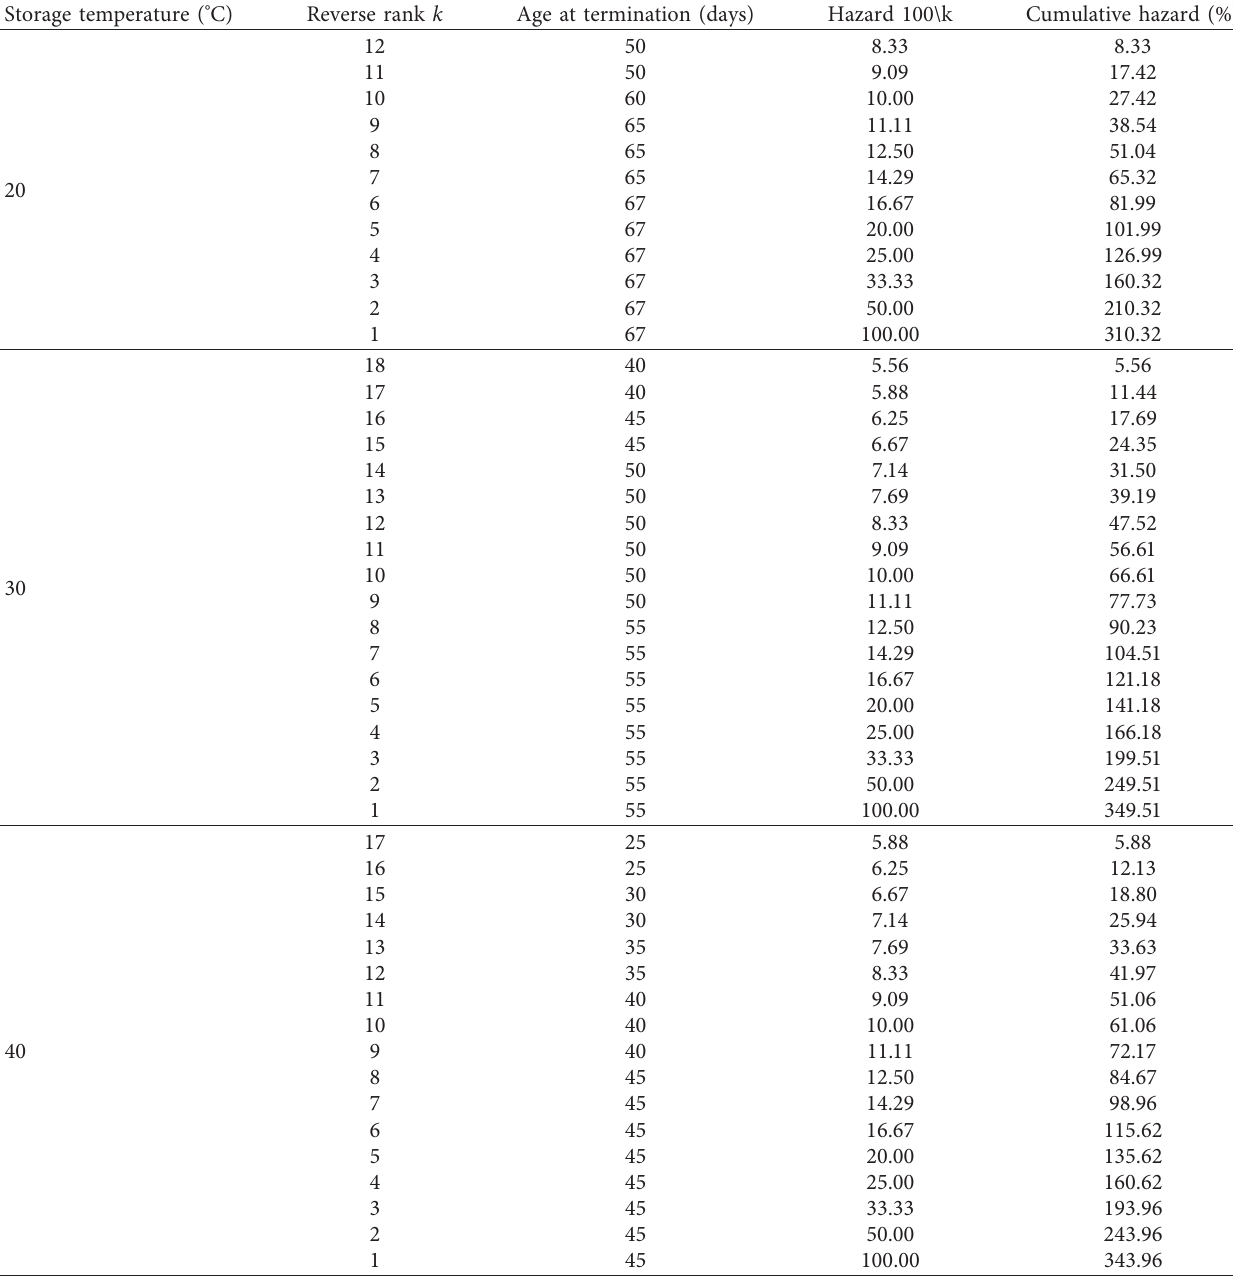
Table 1: Weibull hazard ranking table for tea samples under the ASLT (20 ° C, 30 ° C, and 40 ° C). Storage temperature ( °